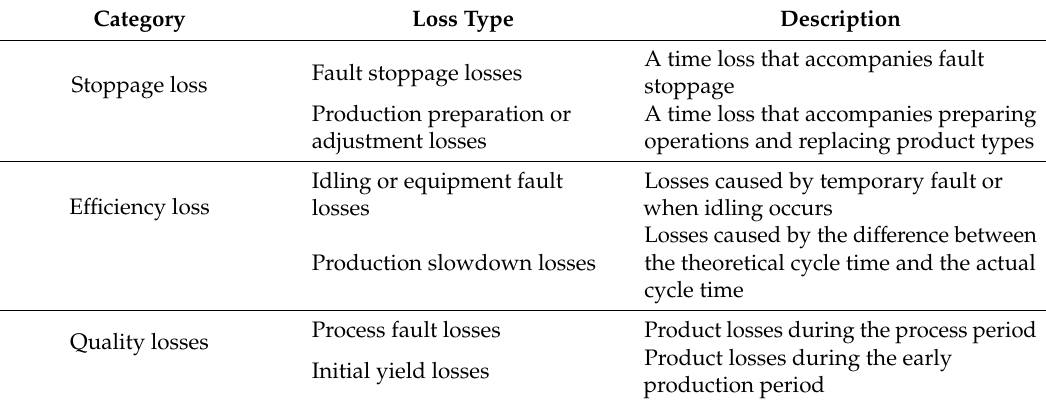
Table 1. Main losses.